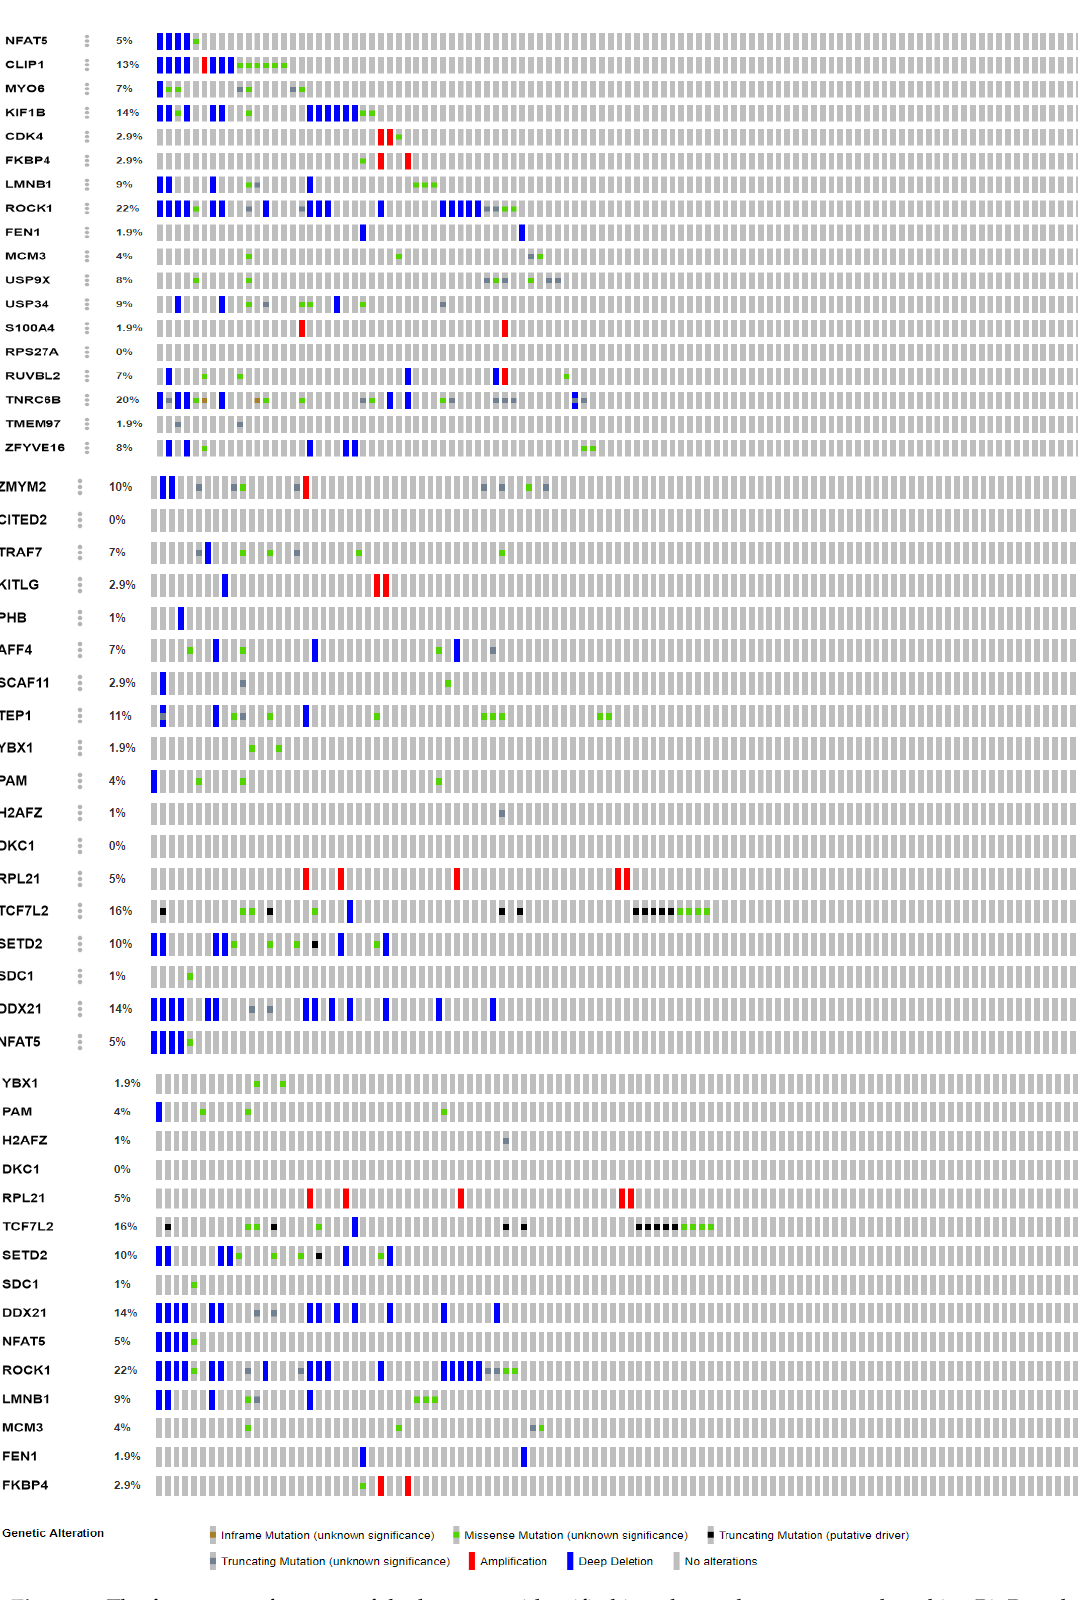
Figure 5. The frequency of reports of the key genes identified in colorectal cancer as analyzed in cBioPortal. Further data mining for the trans-regulatory activities of the identified genes demon- strated that only NFAT5 and TCF7L2 acted as trans-regulatory elements, and the targets of TCF7L2 were identified as ABCB1 , ACVRL1 , CTNNB1 , GATA3 , GLCE , WWC1 , PTGS2 ,